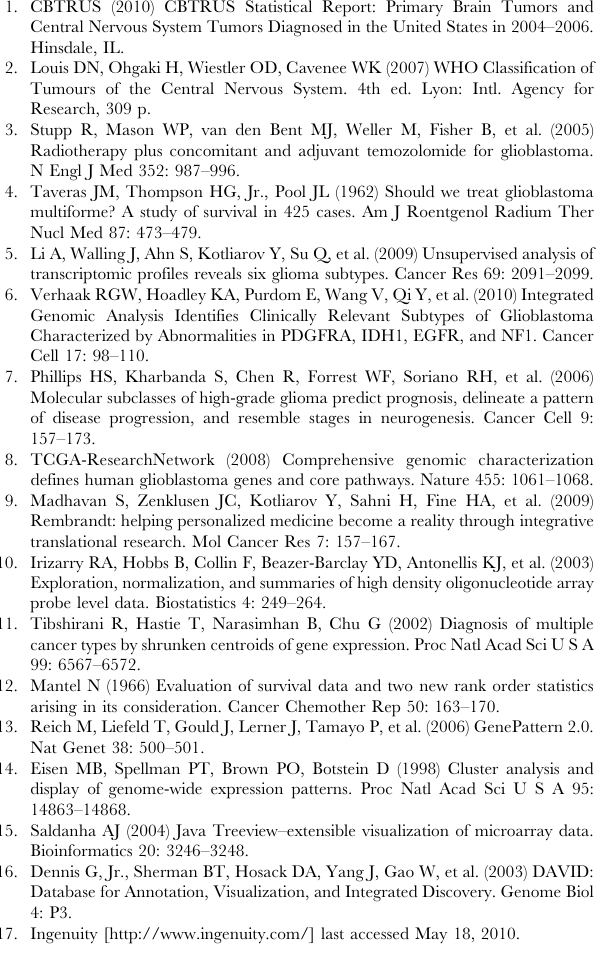
Table S9 Integrated RNA and DNA Copy number analysis comparison of proneural oligodendrogliomas and proneural GBM samples.